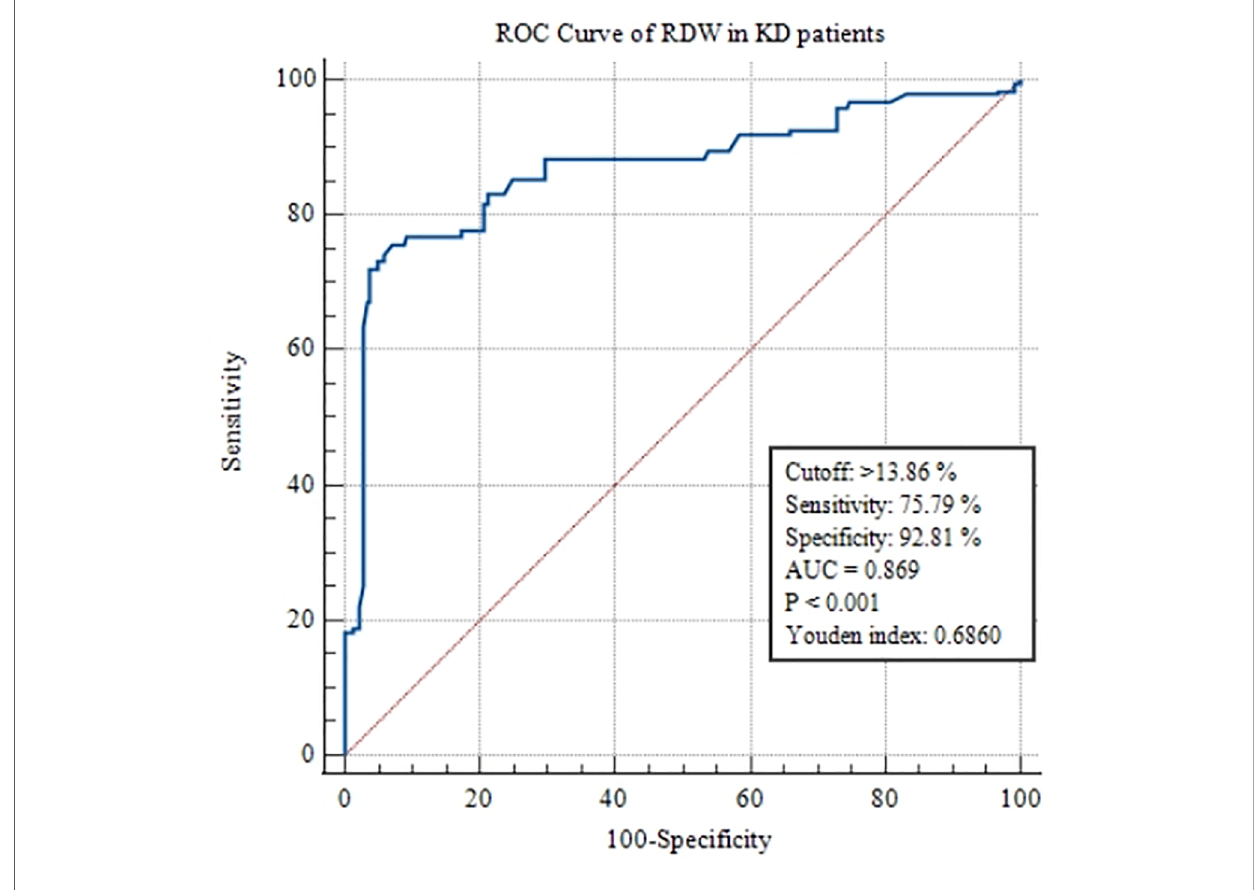
FIGURE 2 ROC curve analysis of RDW to predict CALs in KD patients.